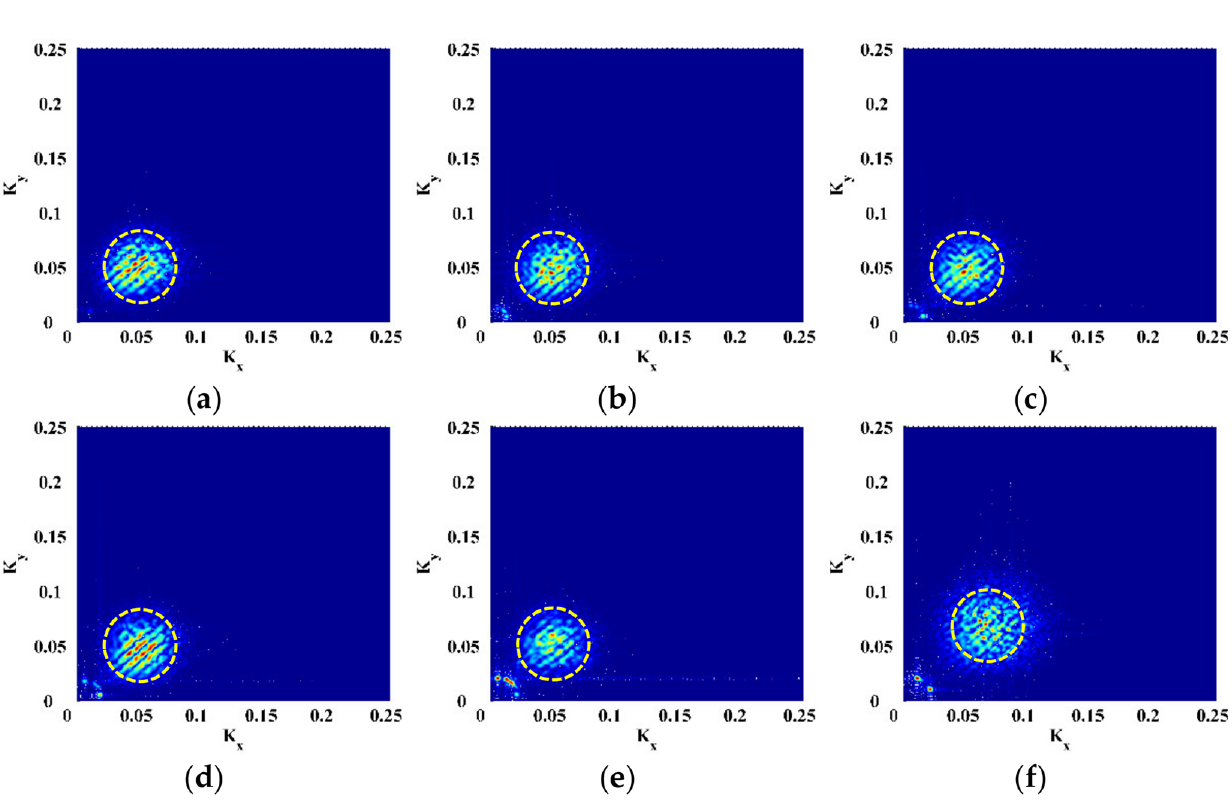
Figure 7. Wavenumber spectra of EMDIs for Scenarios ( a ) I, ( b ) II, ( c ) III, ( d ) IV, ( e ) V, and ( f )